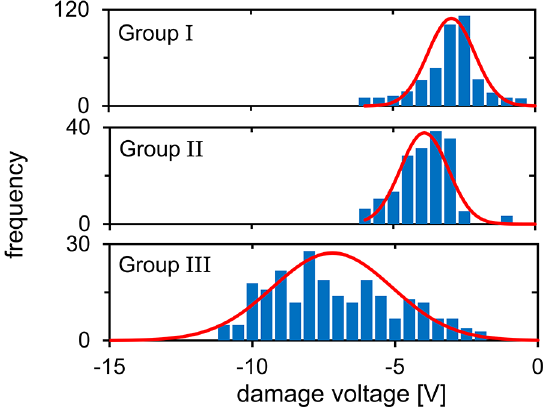
Fig. 3. Histograms of damage voltage in dark reverse bias sweep and the normal distribution curve based on average and standard deviation for all three groups of substrates.